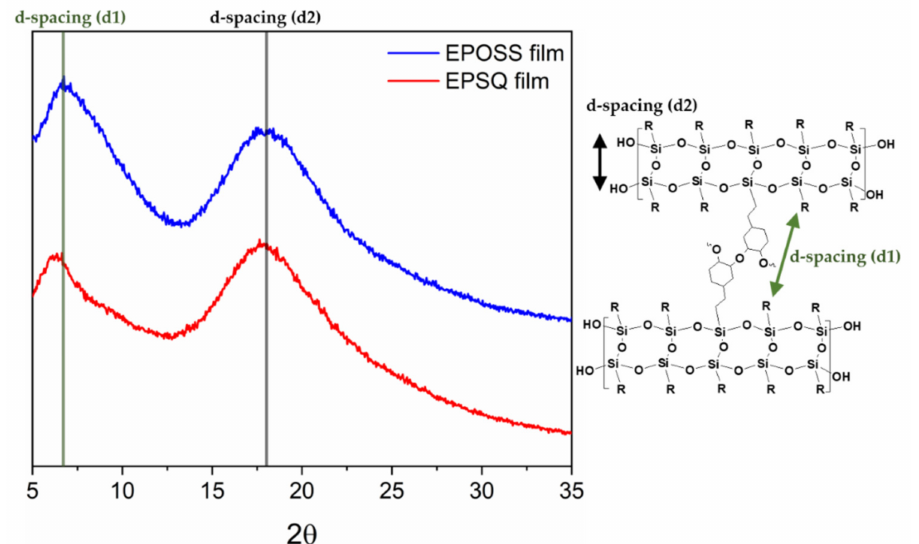
Figure 3. XRD patterns for EPOSS and EPSQ films and schematic representation of intercalated packing structure between EPSQ